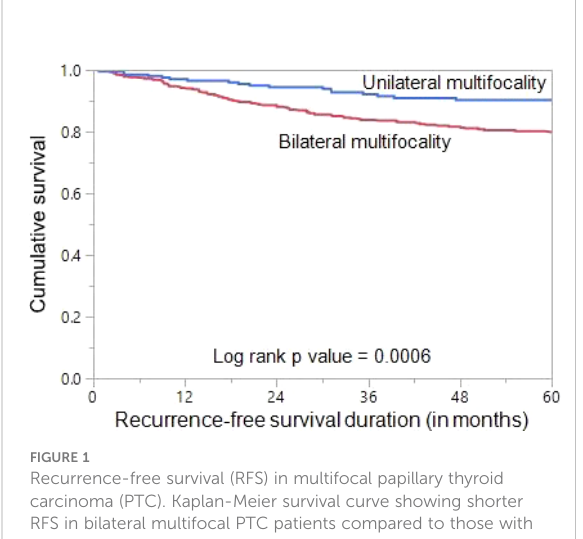
FIGURE 1 Recurrence-free survival (RFS) in multifocal papillary thyroid carcinoma (PTC). Kaplan-Meier survival curve showing shorter RFS in bilateral multifocal PTC patients compared to those with unilateral multifocal PTC (p =